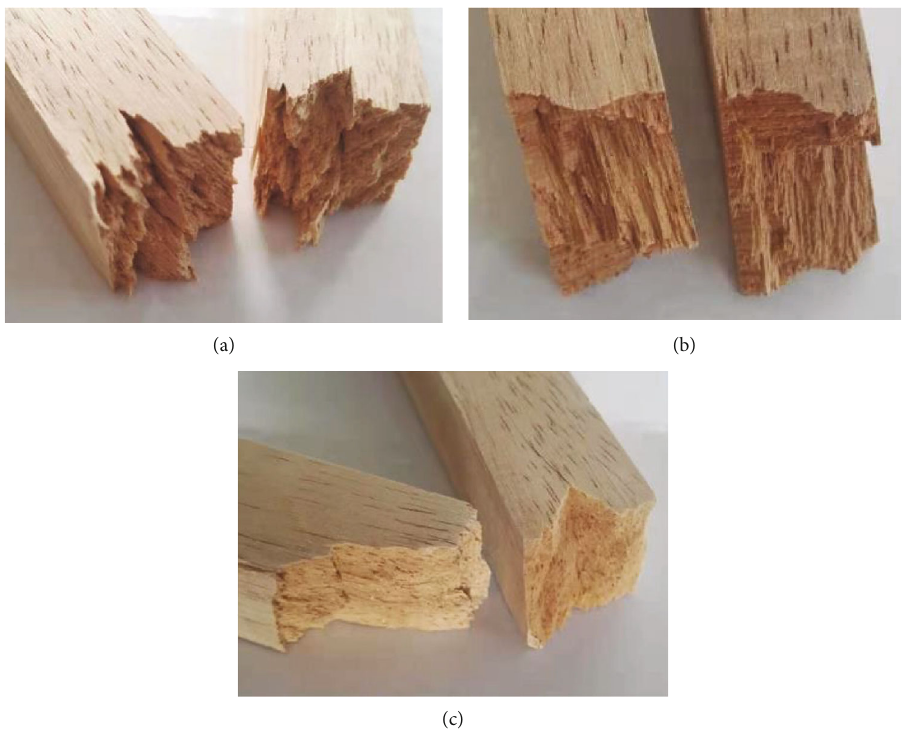
Figure 10: Bending fracture morphology: (a) control wood, (b) 25% MUG-treated wood, and (c) 35% MUG-treated wood.